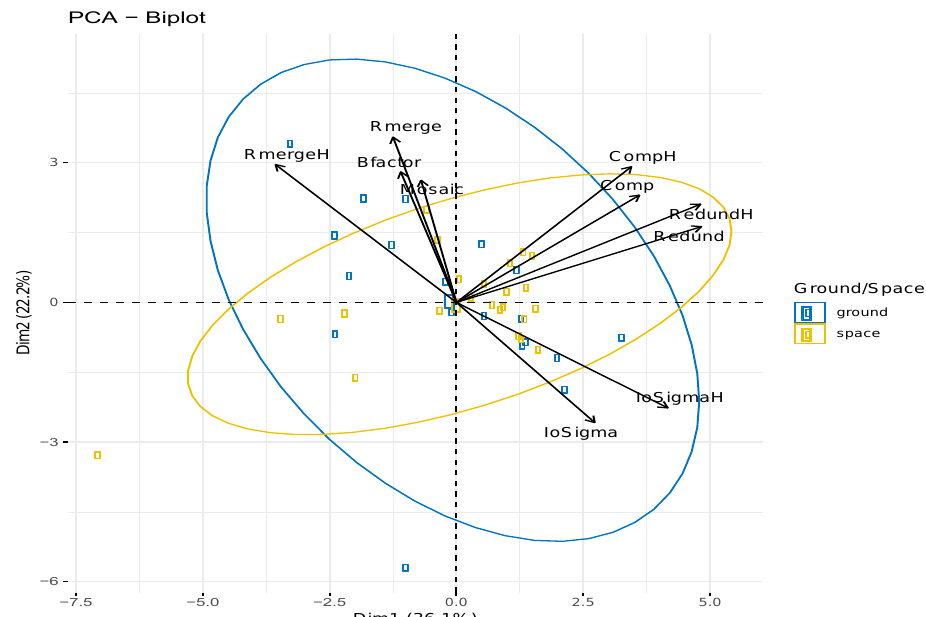
Figure 6. Summary of the PCA analysis on the quality indicators dataset. The plot shows the first and second dimensions of the analysis. The projected direction of each indicator “axis” is indicated by arrows. The indicators for all the crystals in the dataset are plotted as blue / yellow circles for ground / space-grown crystals. The same colors are used to indicate the ellipses encompassing the representative points within the two groups.